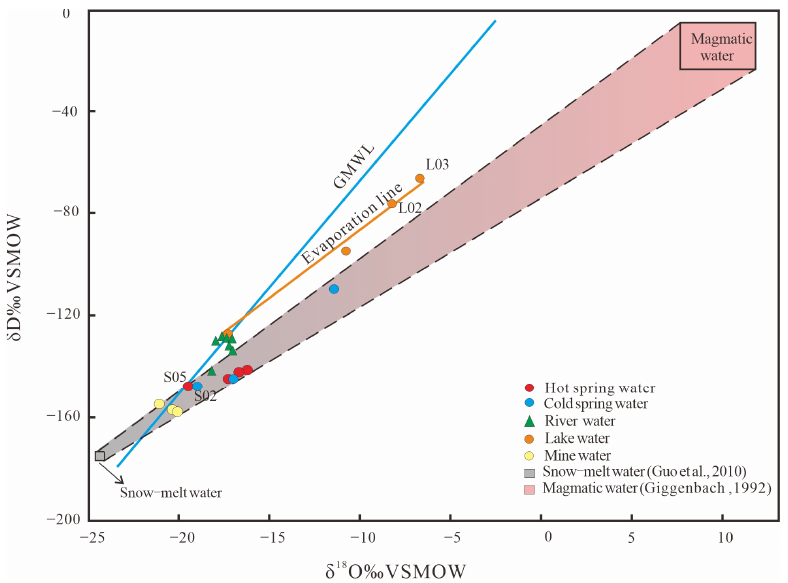
Figure 3. Relationship of δ D vs. δ 18 O in surface water, mine water, cold spring, and hot spring [43,44].